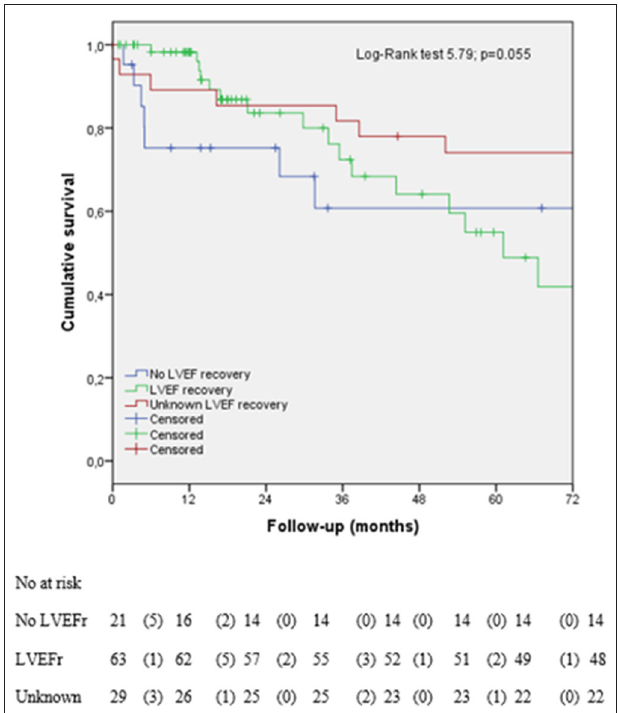
FIGURE 3 | Kaplan–Meier survival analysis according to left ventricular ejection fraction (LVEF) recovery. LVEF, left ventricular ejection fraction; LVEFr, left ventricular ejection fraction recovery. Unknown refers to the patients with lost data about LVEF recovery. Heart transplantation was included as cardiovascular (CV)